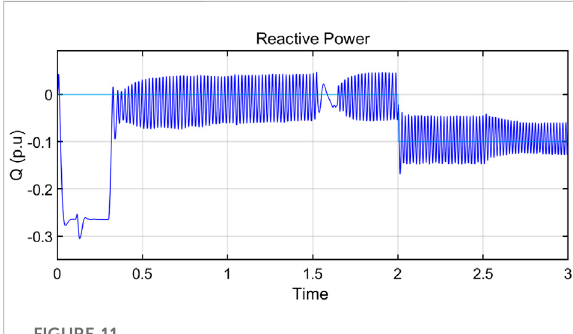
FIGURE 11 Reactive power curve for the proposed controller.